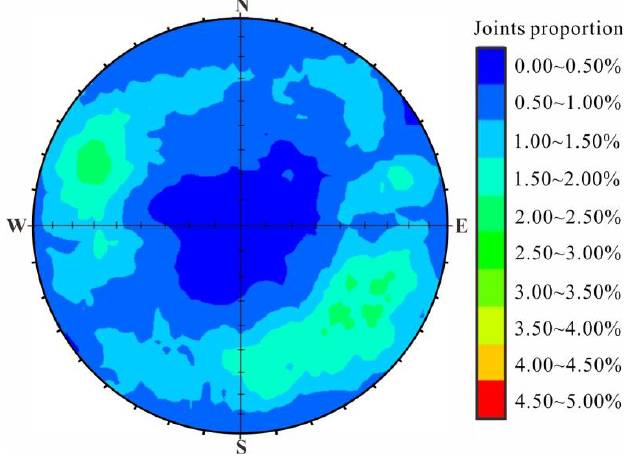
Figure 3. The pole isopycnal map.